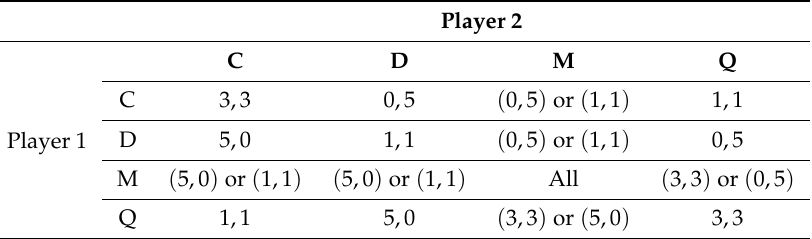
Table 6. The numerical values for the quantum PD game. Player